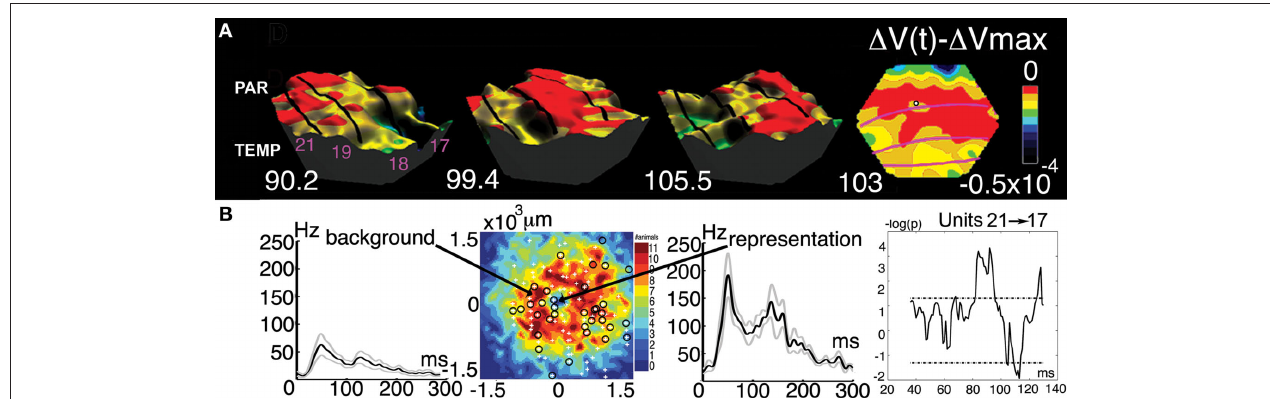
(multiunit activity). The electrode penetration sites in relation to the segmentation of the square from its background in 11 animals. The multiunit activity of neurons mapping the square (standard errors of mean shown). Neurons firing statistically significantly in the cortex mapping the object background between the mapping site at the area 19/21 border and the site in area 17. Note the statistically significant firing at the time the FB passes 86–96 ms and the following significant decrease in the firing rate (modified from Roland et al.,